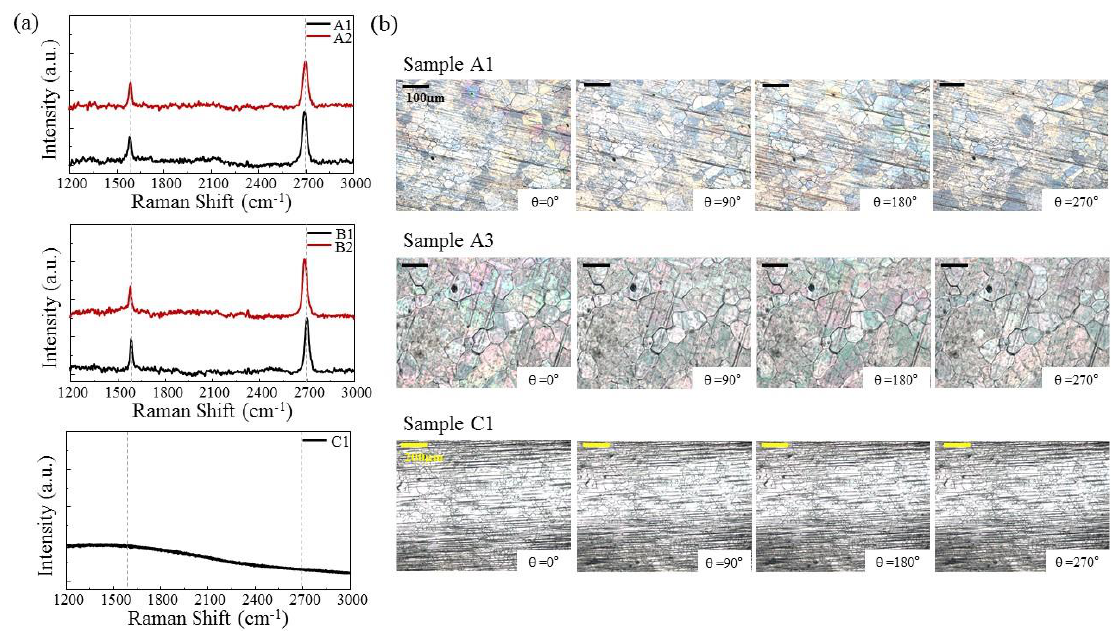
Figure 4. ( a ) Raman spectra of Samples A1, A2 (top), and B1, B2 (middle), and C1 (bottom). ( b ) Polarized Light Microscopy (PLM) images of Samples A1, A3, and C1.